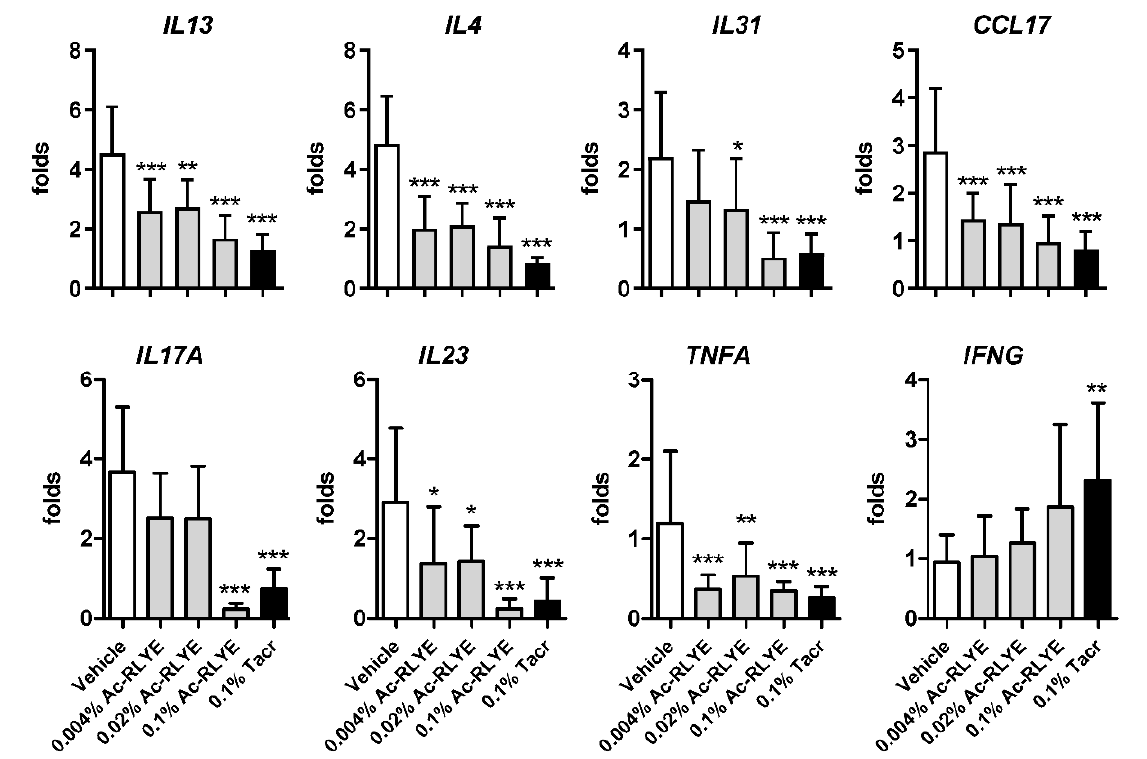
Figure 6. Ac-RLYE decreased the expression of inflammatory cytokines and increased the expression of IFN- γ in AD-like skin lesions of NC/Nga mice. Total RNA was extracted from the dorsal skin of the mice at Day 48. Quantitative PCR was performed to determine the mRNA expression of IL-4, IL-13, TNF- α , CCL17, IFN- γ , IL-17, IL-23, and IL-31. Data are presented as mean ± SD values for each group ( n = 10). * p < 0.05, ** p < 0.01, *** p < 0.001 in comparison to vehicle-treated group.